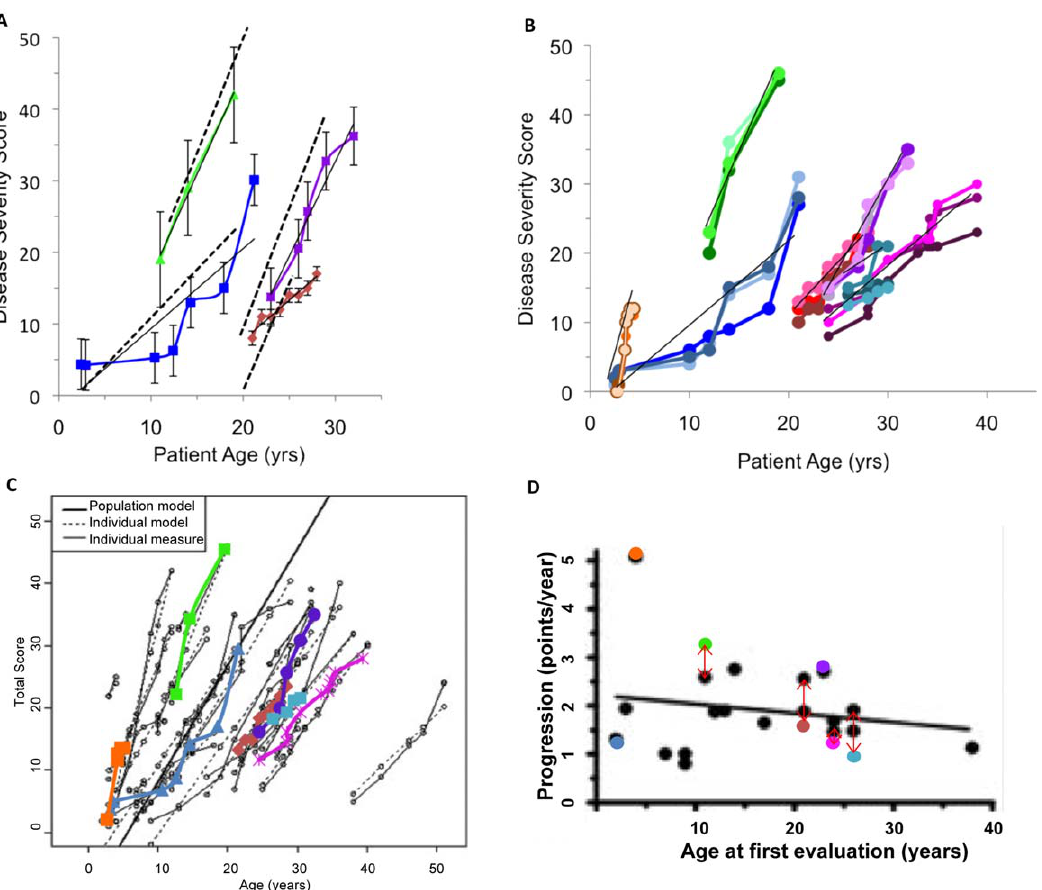
Figure 3. Assessment of four NP-C patient medical records by expanded class sizes. A. Disease severity curves generated by two different classes of sixteen students in Fall 2009 and Spring 2010. From each class groups of three to five students evaluated four NP-C patient’s medical records obtained from Yanjanin et al. 2010. Each group evaluated one patient record. Error bars indicate scoring variation between the two classes. Linear best fit shown as solid black line for each record. Hatched line indicates best fit obtained by Yanjanin et al 2010. Color code: case 1, blue; case 2, red; case 3, purple; case 4 green; B. Disease severity curves generated by thirty students in Spring 2011. Five groups of six students scored the four NP-C medical records from panel A as well as three additional records. Scoring was done by pairs of students and triplicate scores were generated for each medical record as shown. Color code as indicated in panel A as well as case 5, magenta; case 6 orange; case 7, teal. Triplicate curves associated with each case, where each curve indicated pair wise scoring. C. The average of curves shown in panel B overlaid a summary of disease severity curves described in Yanjanin et al. 2010. D. The progression slope shown in panel C was determined by linear regression and overlaid onto the progression slope created by Yanjanin et al. 2010. Red arrows indicate extent of displacement of progression obtained from student assessments. Colors as indicated for panel C. When students’ progression values were used, the progression slope was found to be 1.907 + / 2 0.2374. The original progression slope calculated by Yanjanin et al. 1.923 + / 2 0.2200.